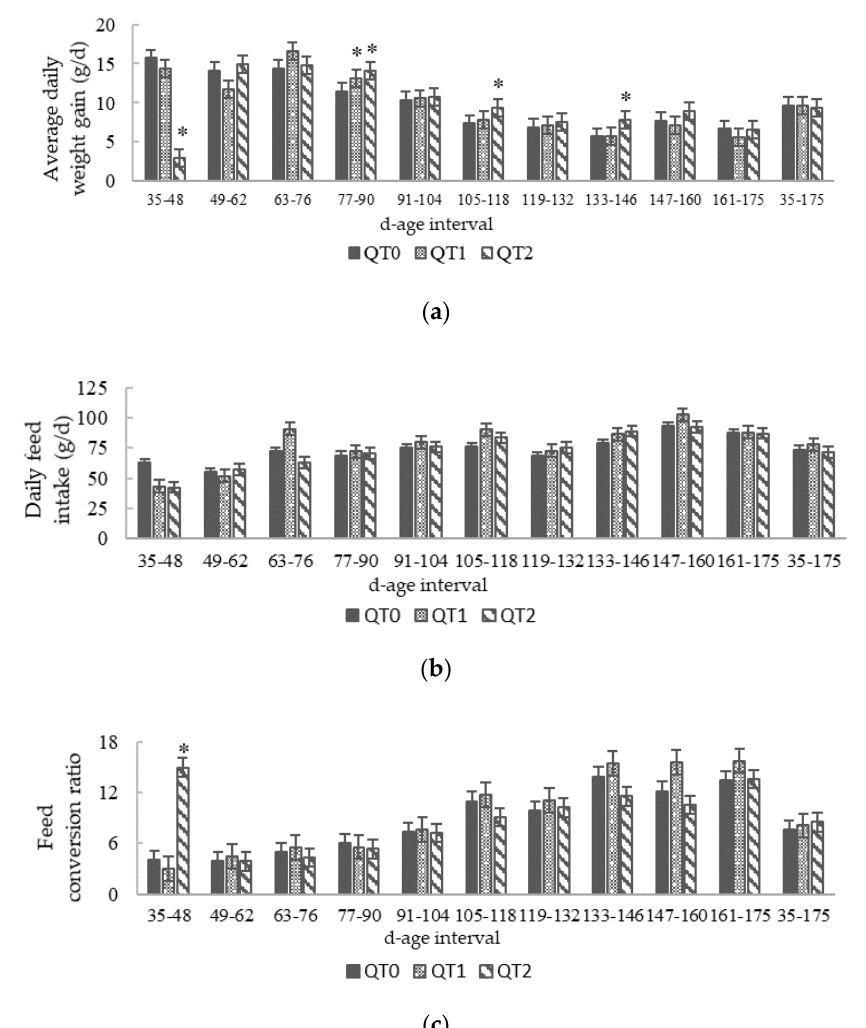
Figure 2. Trends in: ( a ) Average daily weight gain; ( b ) Daily feed intake; ( c ) Feed conversion ratio from birds fed different levels of QT (mean ± SEM) for a 140-day period starting from 35 days old. * Indicates a difference between treatment and QT0 (Dunnett’s t -test, p < 0.05). QT0 = basal diet; QT1 and QT2 = the basal diet supplemented with QT at 1% and 2%, respectively.